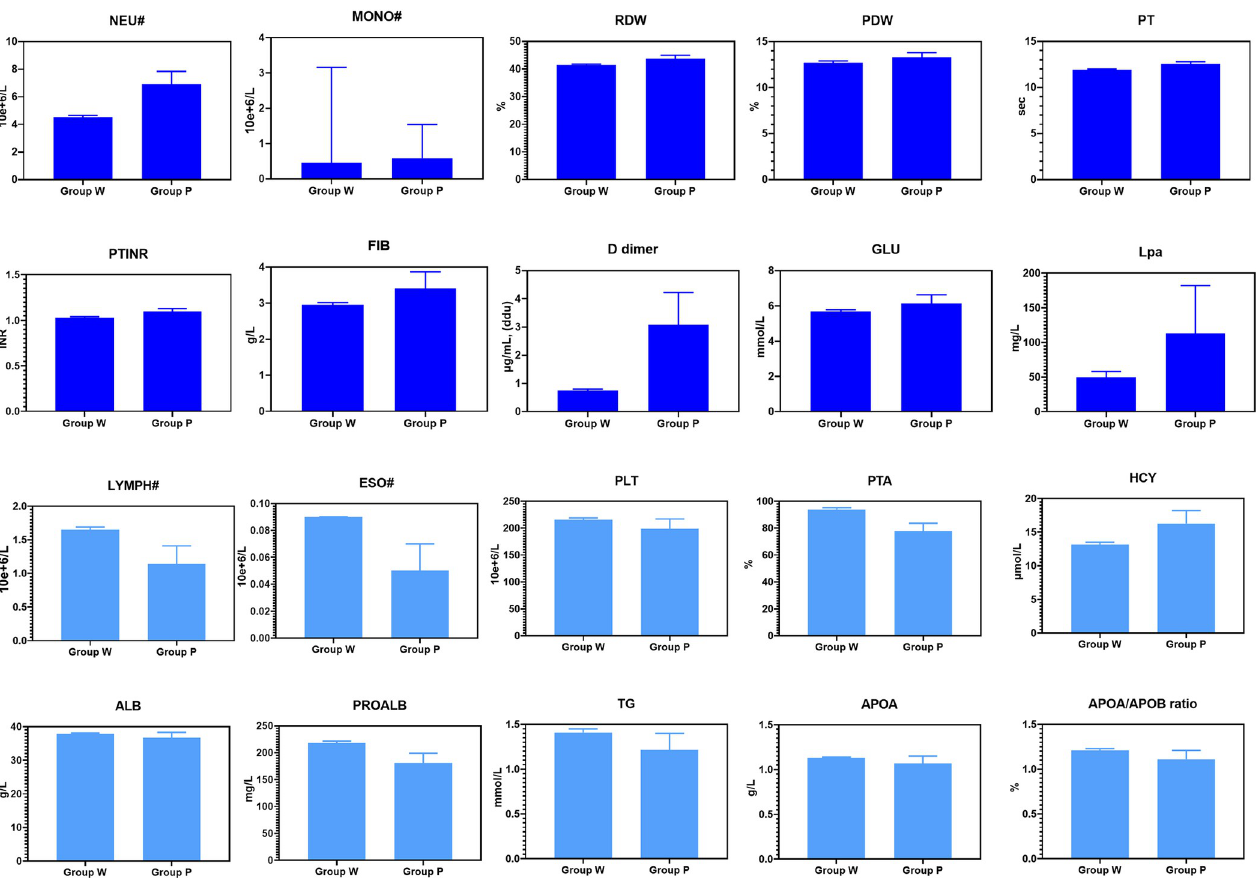
Fig 3. Compared result of significant subitems between Group W and Group P ( P < 0.05 � , median with 95 CI). Items marked in dark blue are items higher in Group P than in Group W, and items marked in light blue are items lower in Group P than in Group W. This figure only shows the items with statistical